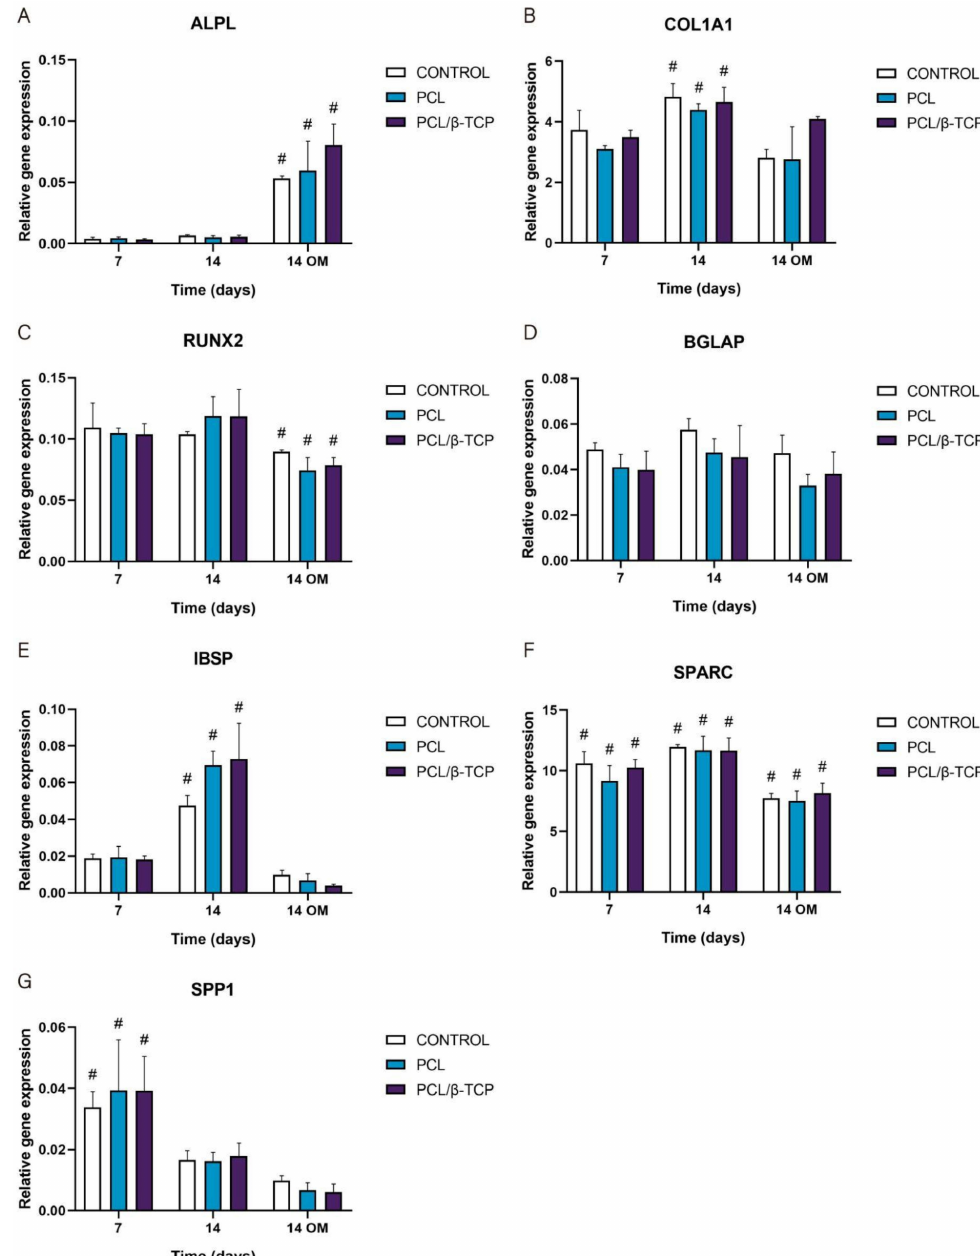
Figure 10. Quantitative real-time polymerase chain reaction results of osteogenic markers after 7 and 14 days of culture. The results are expressed as mean ± SD. # Significant differences between the marked group at different time periods ( p > 0.05). No significant differences were observed between the groups in the same time period. ( A ) ALPL, alkaline phosphatase; ( B ) COL1A1, collagen type I; ( C ) RUNX2, runt-related transcription factor 2; ( D ) BGLAP, osteocalcin; ( E ) IBSP, integrin-binding sialoprotein; ( F ) SPARC, osteonectin; ( G ) SPP1,